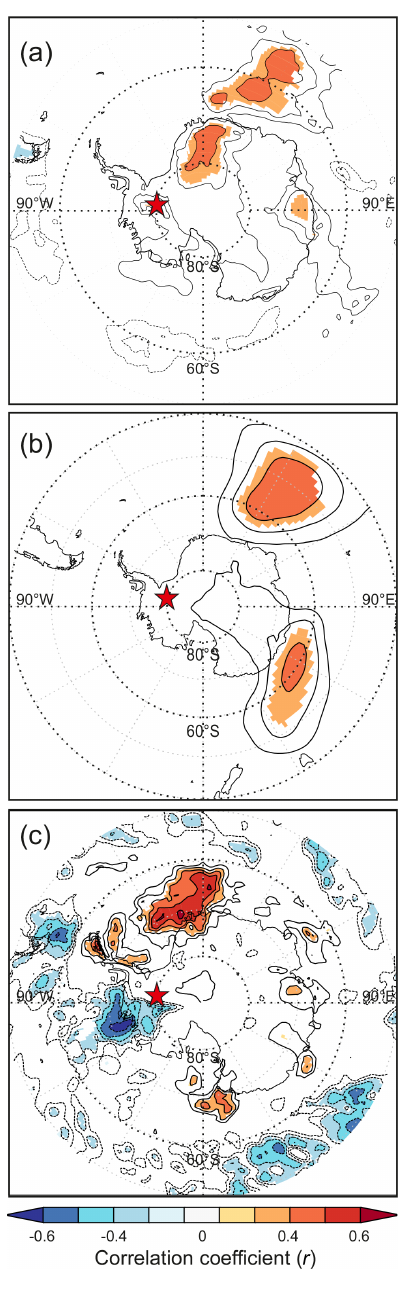
Figure 9. Spatial correlations ( r ) of annually averaged ERA- Interim (a) near-surface air temperatures (2m), (b) geopotential heights (850mbar) and (c) precipitation–evaporation with standard- ized mean annual (a) δ 18 O, (b) d excess and (c) snow accumulation in the UG region (red star) for the period 1980–2014 (excluding firn core GUPA-1). All time series were detrended before calcu- lating spatial correlations. Only statistically significant correlations ( p < 0 . 05) are displayed. For (a) and (c) December–November an- nual averages (calendar year) were used, whereas for (b) August– July annual averages (winter–winter) were considered as spatial correlations appear more significant than for December–November annual